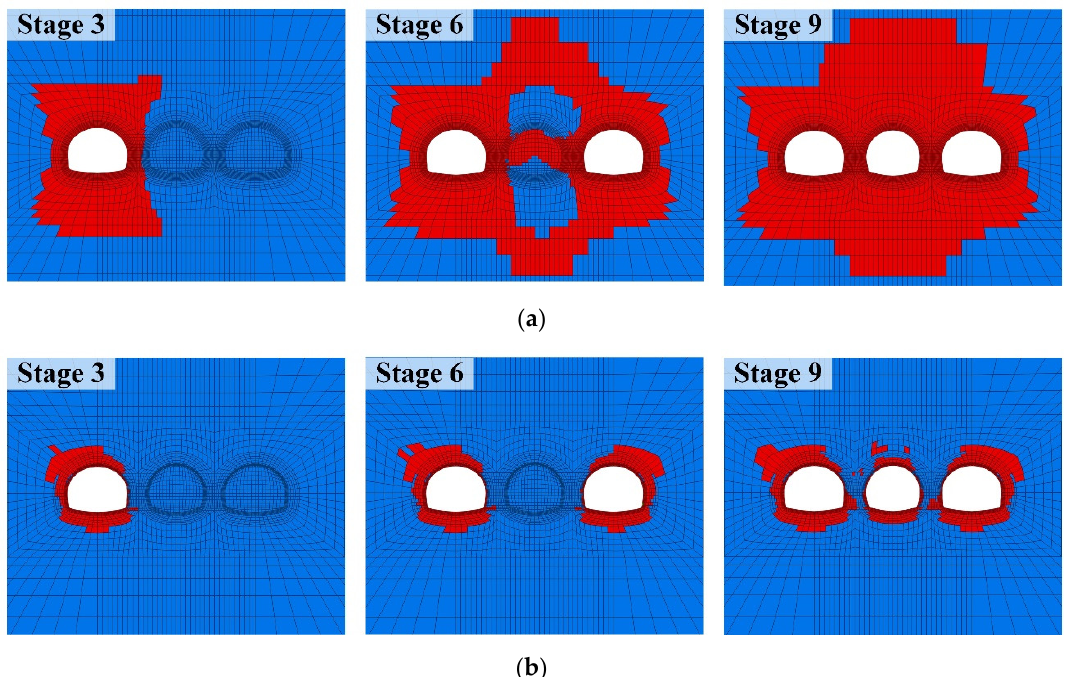
Figure 15. Development of plastic zone (red elements) around triple tunnels: ( a ) without PRPS or CGPR (Case 1); ( b ) with PRPS and CGPR (Case 2).